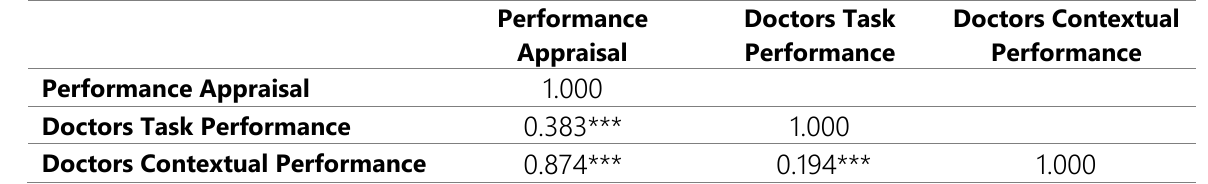
Table 2: Correlation analysis between performance measures.